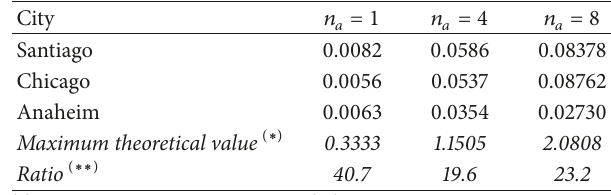
Table 1: Strategic network indicators by city. Table 2: Maximum value of 𝜙 for each network and 𝑛 𝑎